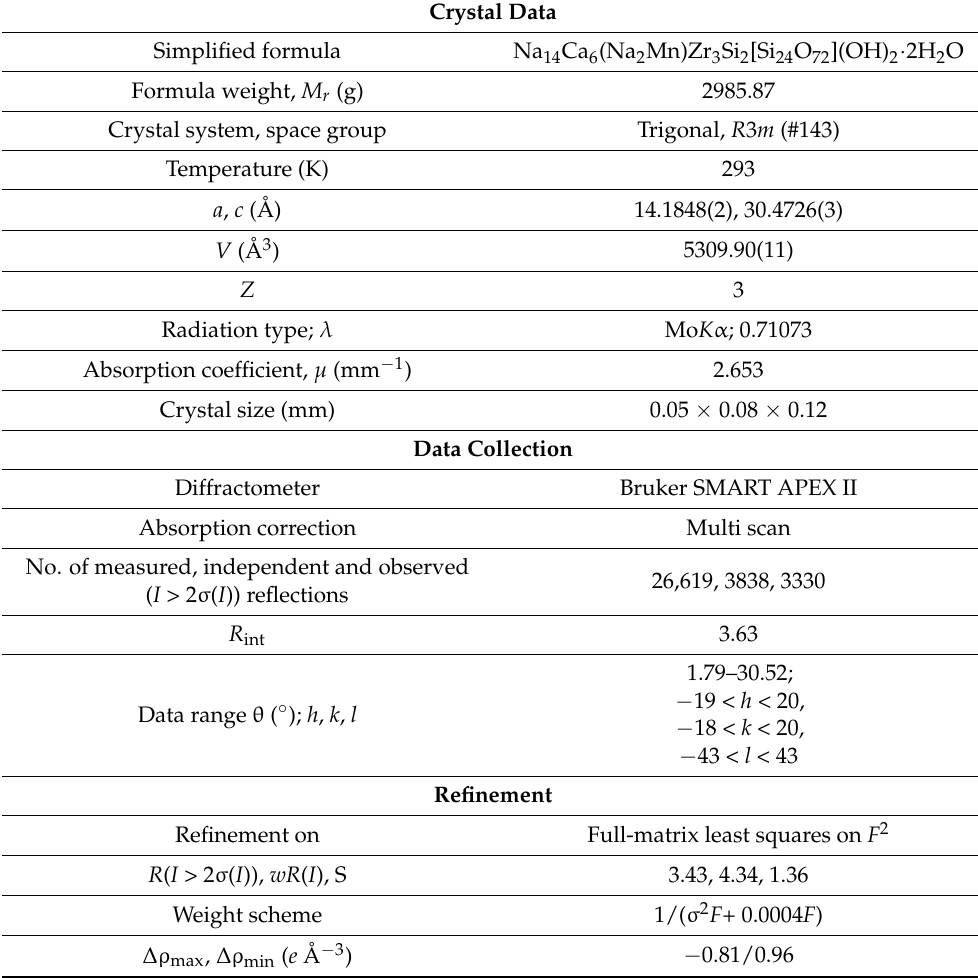
Table 2. Crystal data, data collection information and structure refinement details for Mn-deficient